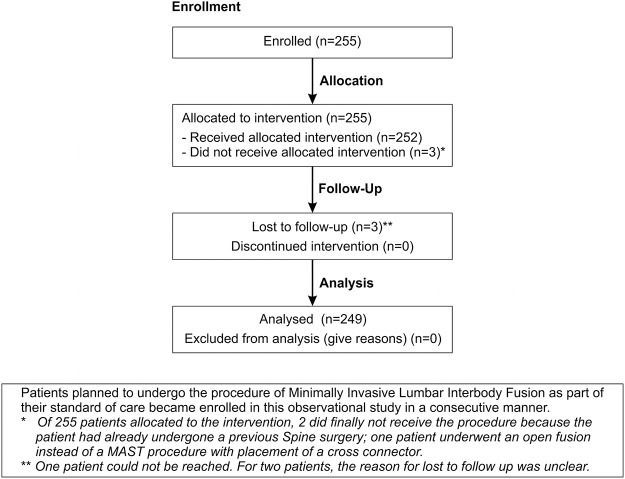
Flow diagram of patient follow up.